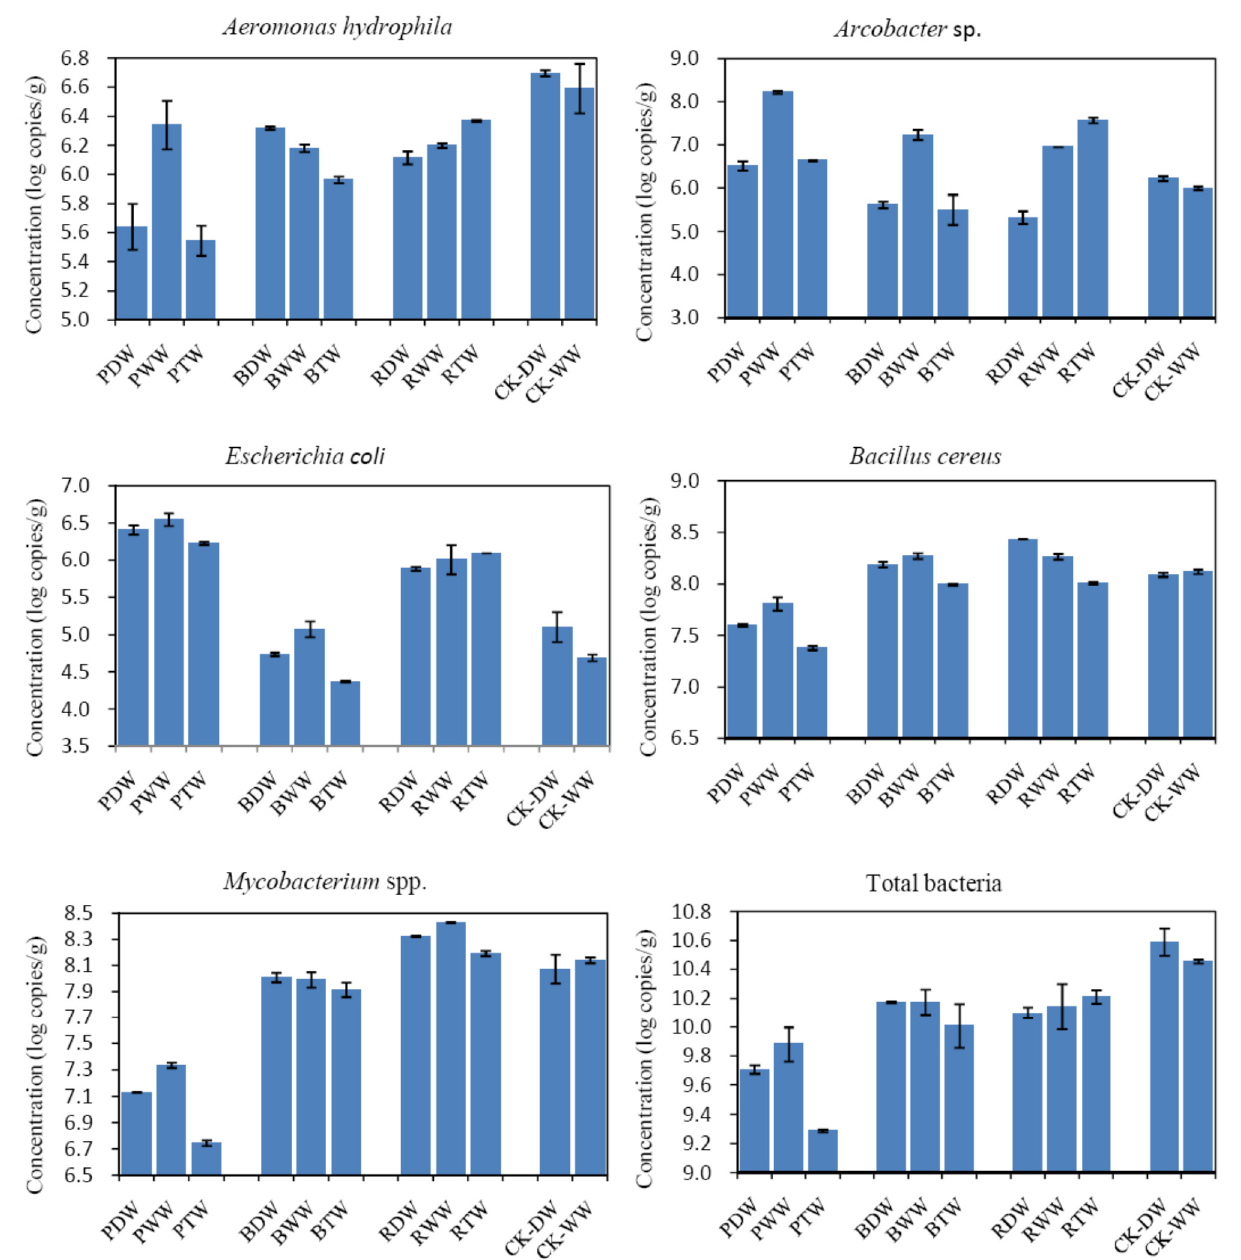
Figure 3. Pathogenic bacteria in each sample. Abbreviations: PDW, phyllosphere irrigated with tap water; PWW, phyllosphere irrigated with wastewater; PTW, phyllosphere irrigated with treated wastewater; BDW, non-rhizosphere irrigated with tap water; BWW, non-rhizosphere irrigated with wastewater; BTW, non-rhizosphere irrigated with treated wastewater; RDW, rhizosphere irrigated with tap water; RWW, rhizosphere irrigated with wastewater; RTW, rhizosphere irrigated with treated